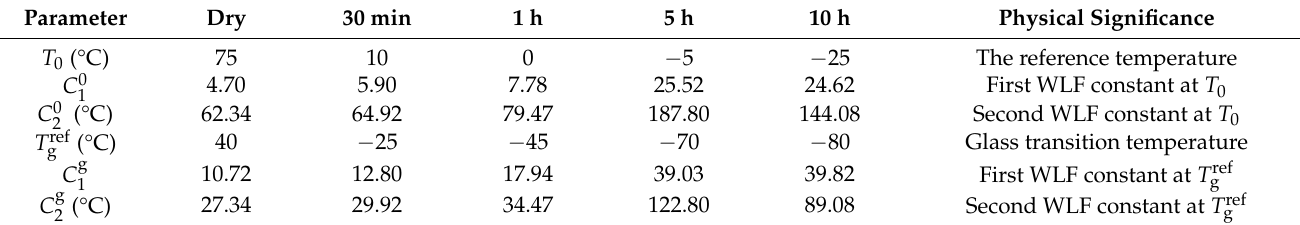
Table 2. Parameters of Williams–Landel–Ferry (WLF) constants for polymers with 2 wt.% crosslink density. Parameter